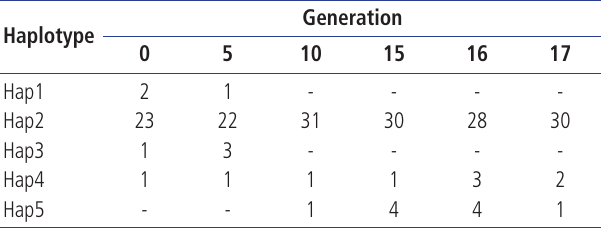
Table 3. The number of haplotypes in different generations for the Langshan conservation population Haplotype